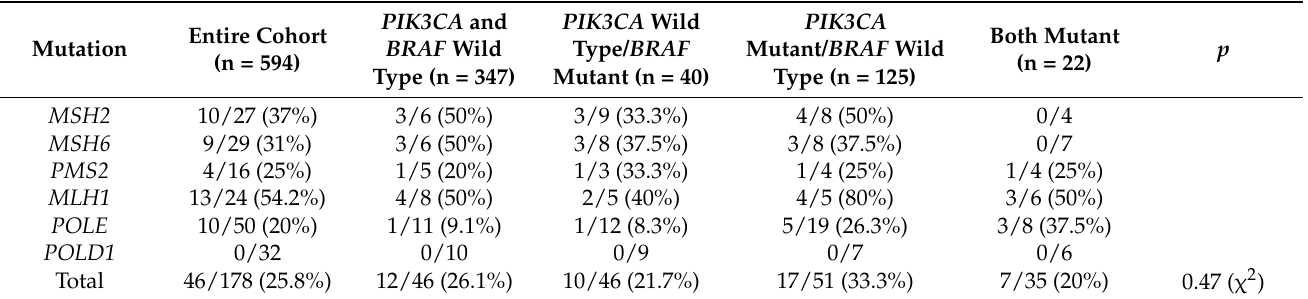
Table 7. Prevalence of functionally annotated mutations as oncogenic/probably oncogenic in MMR and proof-reading polymerases associated genes in TCGA. The nominator in each case represents number of oncogenic or probably oncogenic mutations and the denominator represents the total number of mutations of each gene in each group.